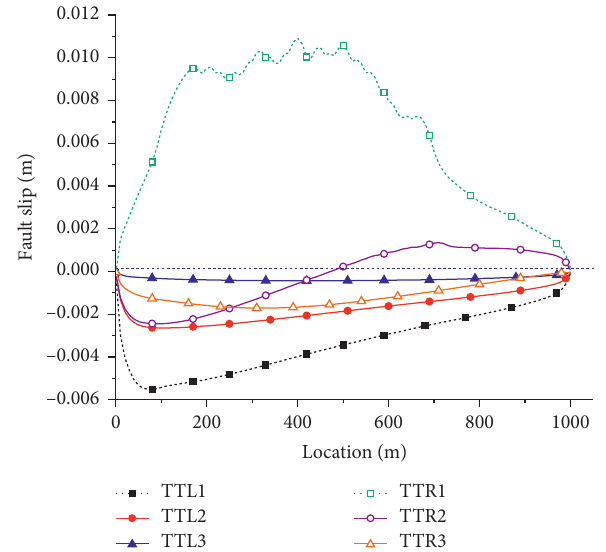
Figure 11: Fault slip along the fault plane when the region TT changed in the horizontal direction.